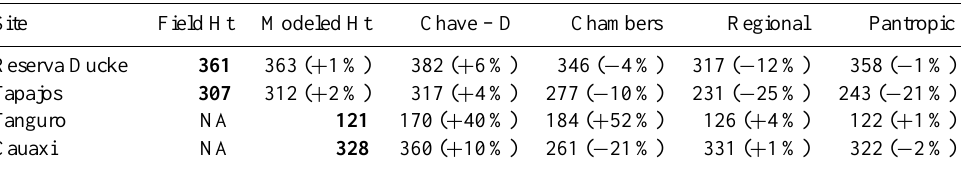
Table 5. Above-ground biomass estimate based on various allometries for the field sites detailed here. The two Tapajos sites (Tapajos km 67 and Tapajos km 83) are combined due to minimal difference in site-specific allometries. The biomass allometries applied are the Chave et al. (2005) Model I allometry including wood density, diameter and field-measured tree height (“Field Ht”); the Chave et al. (2005) Model I allometry with site-specific model of diameter–height (“Modeled Ht”); the Chave et al. (2005) Model II equation without a height term (“Chave – D”); the Chambers et al. (2001) allometry based purely on diameter; the Chave et al. (2005) Model I allometry including height modeled using the Feldpausch et al. (2011) regional equation (“Regional”); and the Chave et al. (2005) Model I allometry including height modeled using the Feldpausch et al. (2011) pantropical height allometry (“Pantropic”). Percent difference from the field height value is shown for Reserva Ducke and Tapajos, and from the modeled height for Tanguro and Cauaxi. This is referred to as the reference case in the text and emboldened here.